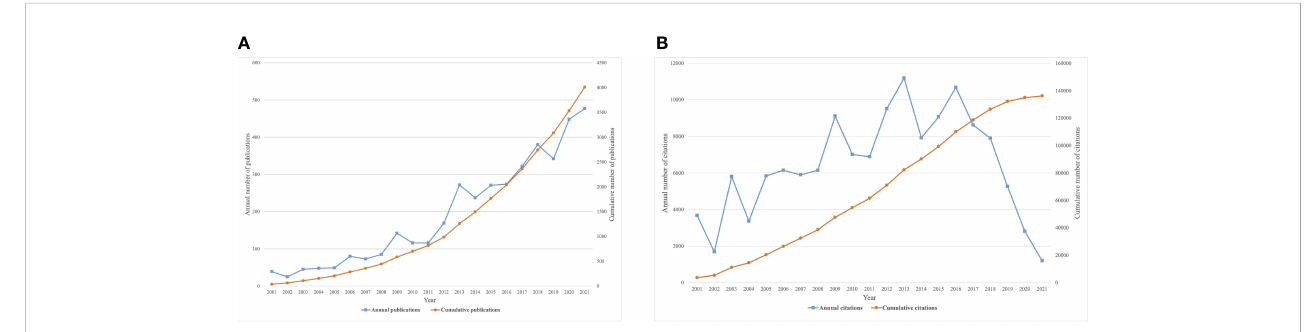
FIGURE 2 Number of publications and citations of SB, PA, and cancer. (A) Annual and cumulative number of publications; (B) Annual and cumulative number of citations.